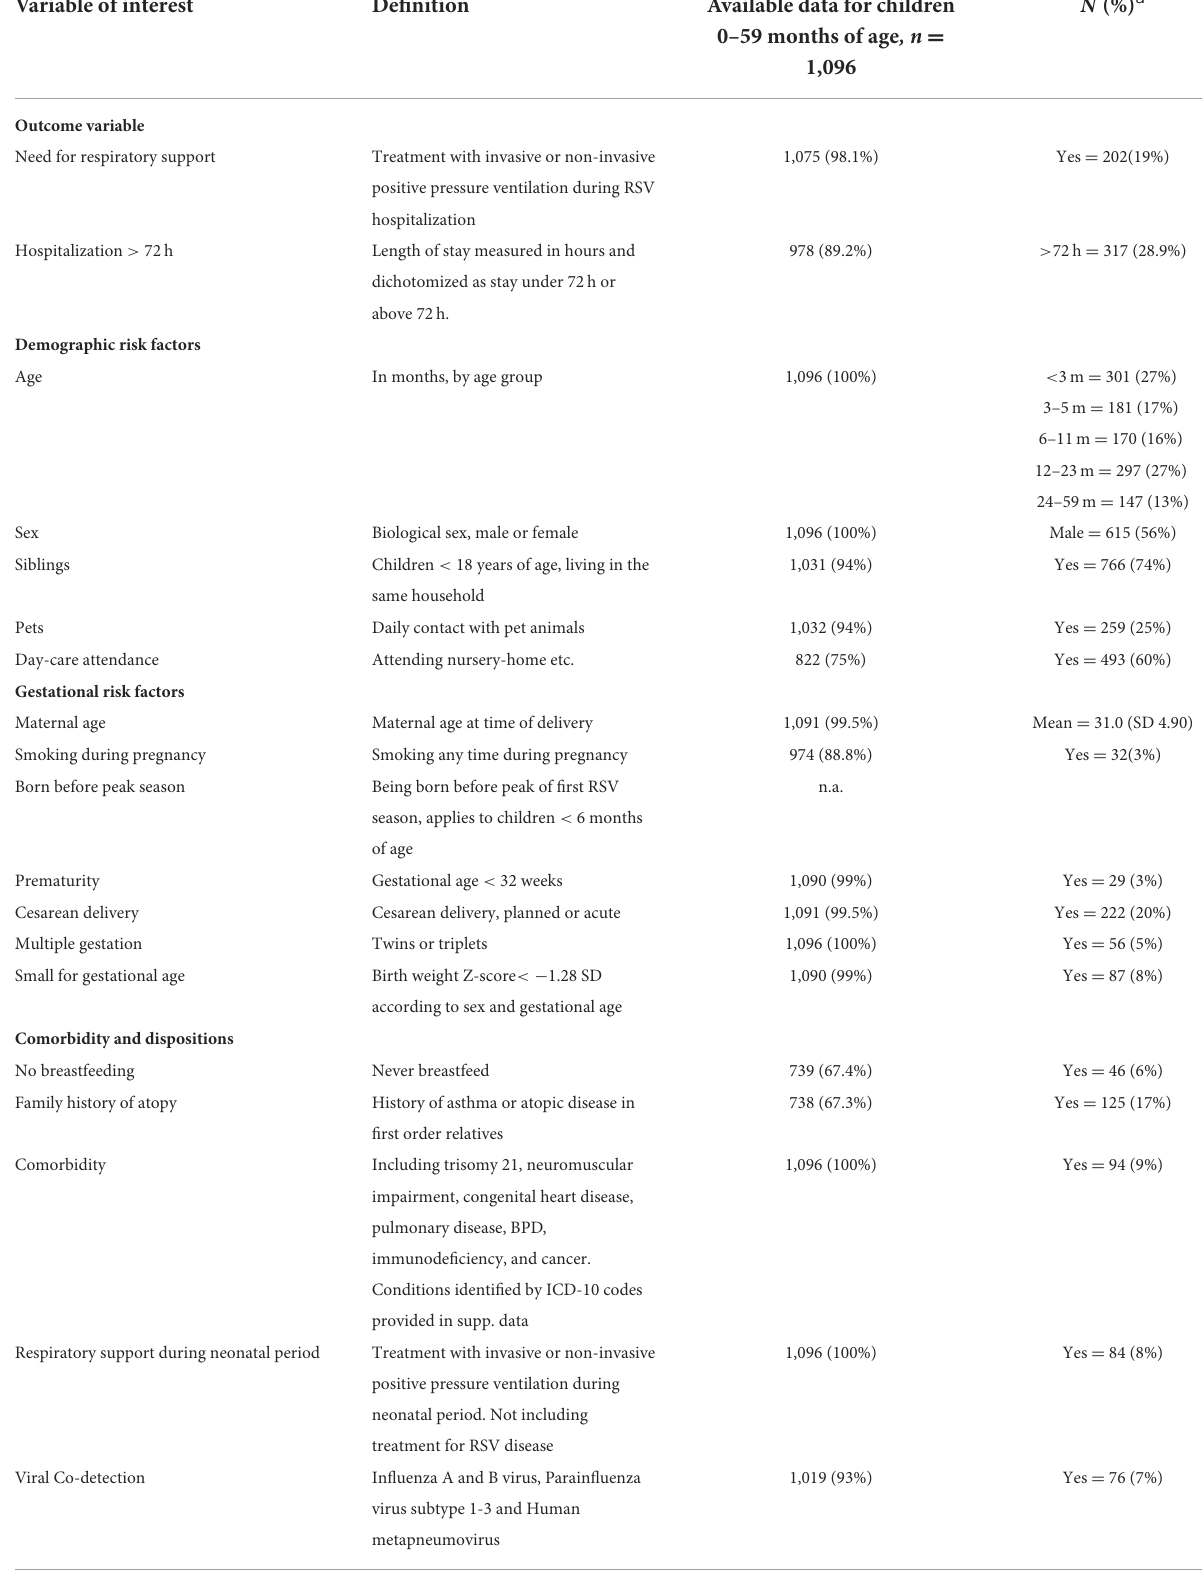
TABLE 1 Summary of the variables in the association analysis including the amount of data available for each